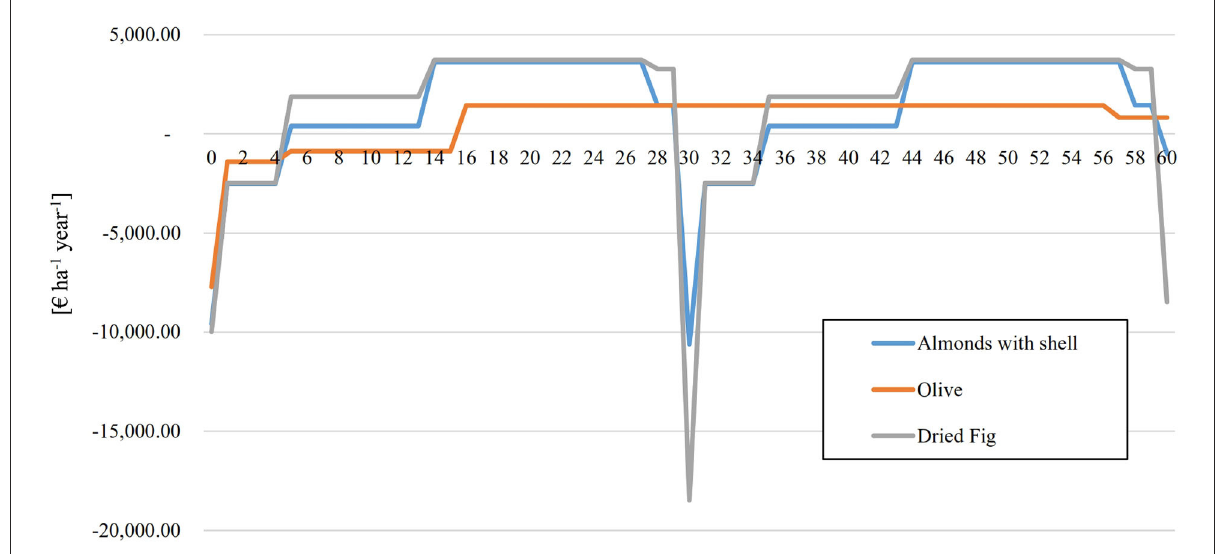
FIGURE5 Net cash flows of the crop life cycle (Source: Authors’ elaboration).